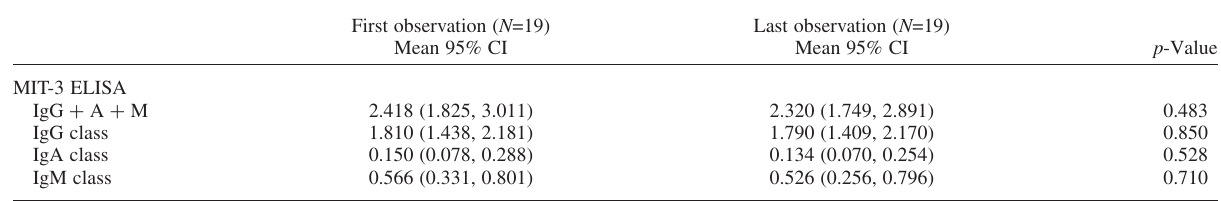
TABLE IV AMAs against the recombinant triple expression hybrid clone autoantigens, MIT3 First observation ( N =19) Last observation ( N =19) Mean 95%